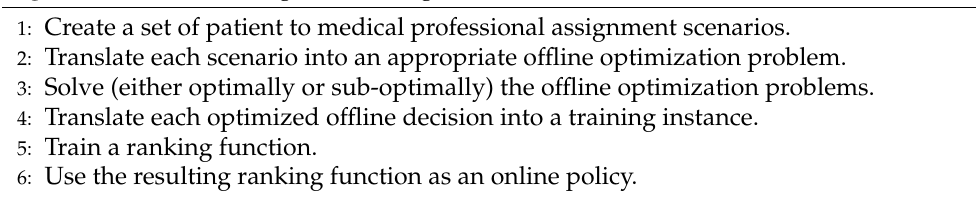
Algorithm 1 The Learning-Based Assignment